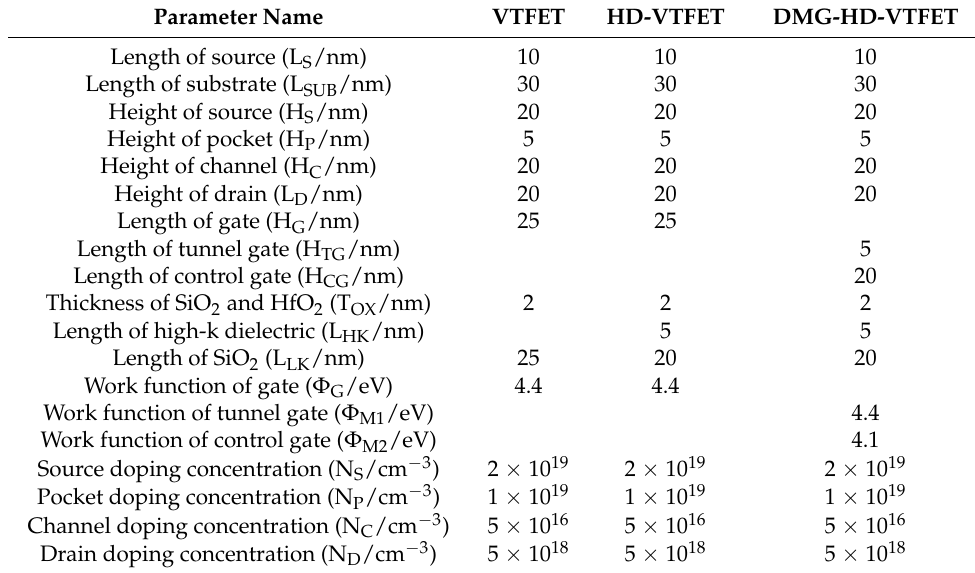
Table 1. The fundamental geometrical and physical parameters of the different devices